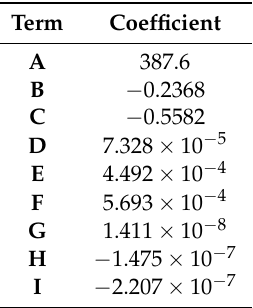
Table 5. Polynomial coefficients for approximating the fuel function.